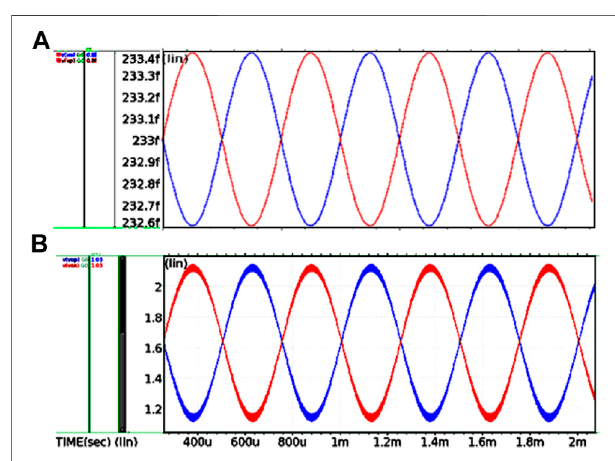
FIGURE 6 | Simulation of readout circuit, (A) input signal, (B) demodulated output